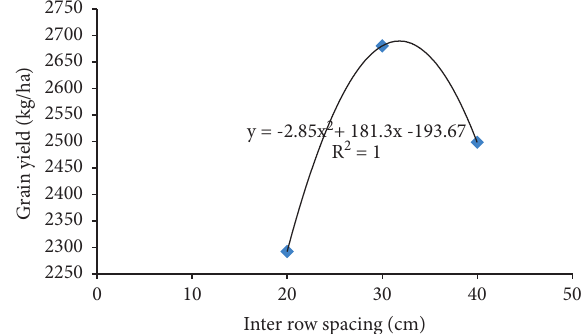
Figure 4: Relationship between intrarow spacing and grain yield of